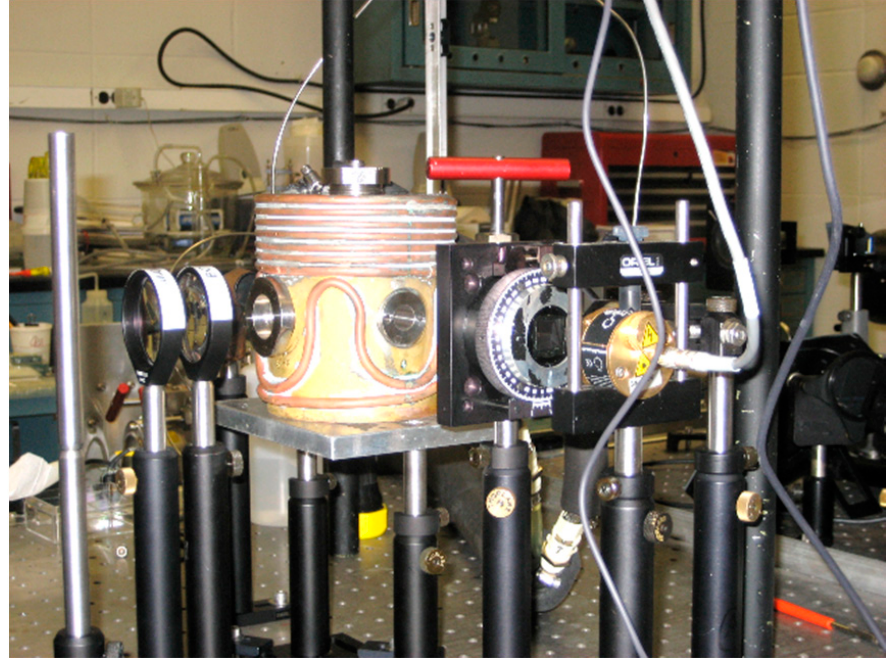
Figure 4. A four-window high-pressure cell built into a pulsed-laser flash photolysis unit with an optical detection system, using the pill-box cell shown in Figure 2, which allows a perpendicular alignment of the laser beam and optical detection system.